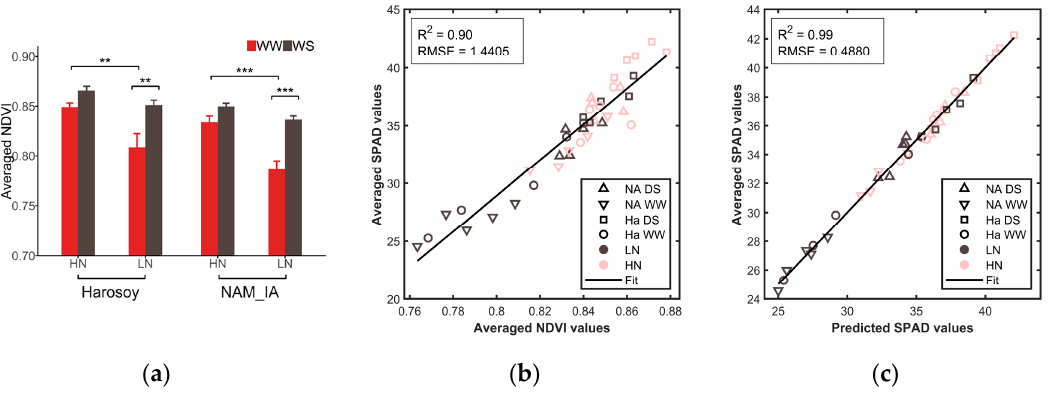
Figure 8. Averaged NDVI and averaged SPAD values of different groups. ( a ) Averaged NDVI by LeafScope for each leaf (P < 0.01 for genotype, P < 0.0001 for water, P < 0.0001 for N by three-way ANOVA). Data are represented as mean ±SE (n = 5). *P < 0.05, **P < 0.01, ***P < 0.001. ( b ) Relationship between averaged NDVI and averaged SPAD. ( c ) Relationship between predicted SPAD values by LeafScope and measured SPAD values by SPAD meter. DS for drought-stressed, WW for well-watered, LN for low nitrogen, HN for high nitrogen, NA for NAM_IA genotype, and Ha for Harsoy genotype in ( b , c ).